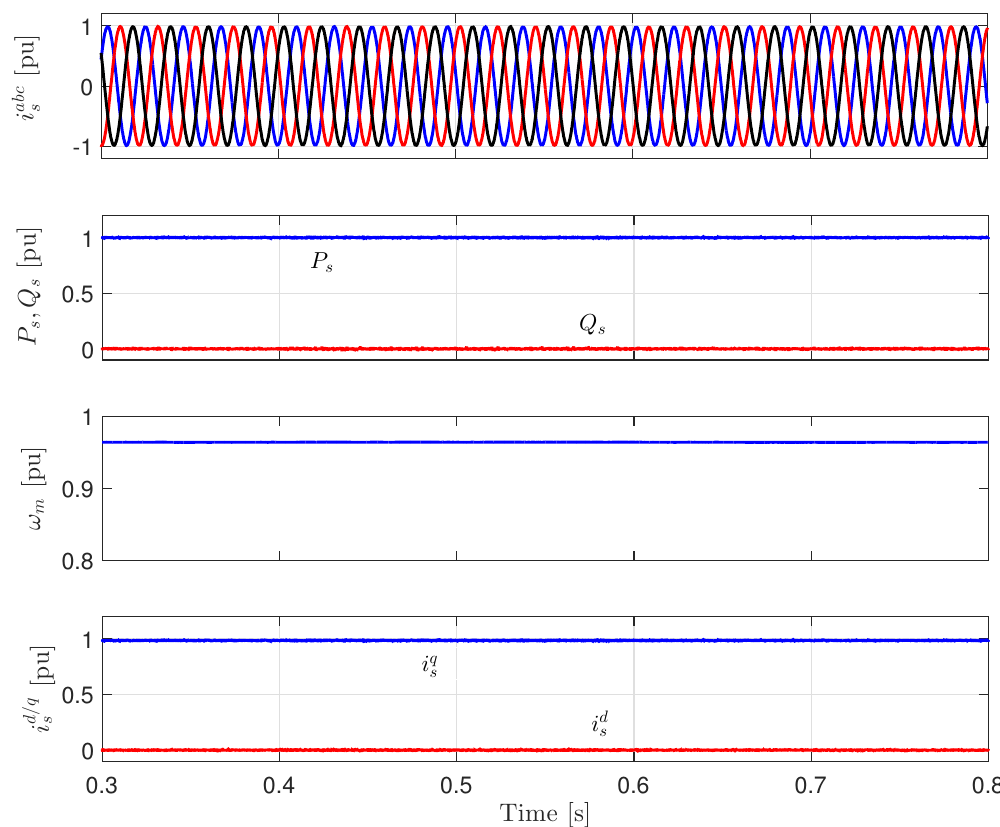
Figure 5. Performance of the MSC and PMSG during a three-phase fault with BC-FRT strategy (from top ): PMSG output currents i abc s = ( i a s , i b s , i c s ) (cid:62) , PMSG active and reactive power ( P s , Q s ), mechanical speed of the PMSG rotor ω m , and d - and q -axis currents of PMSG ( i d s , i q s